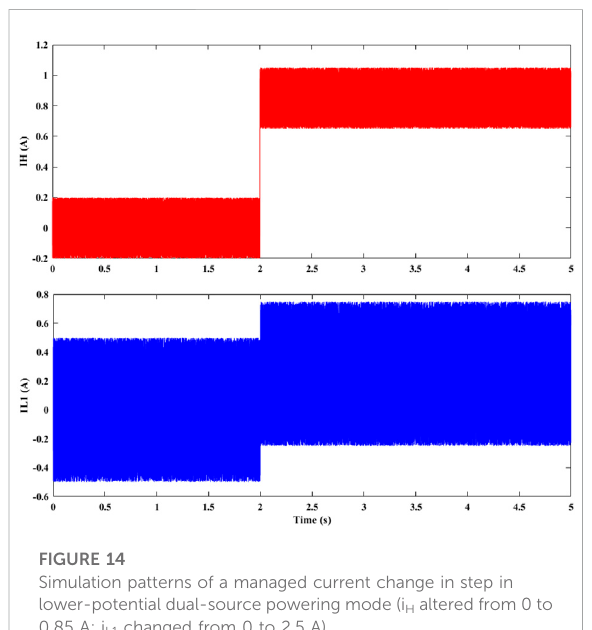
FIGURE 14 Simulation patterns of a managed current change in step in lower-potential dual-source powering mode (i H altered from 0 to 0.85 A; i L1 changed from 0 to 2.5 A).